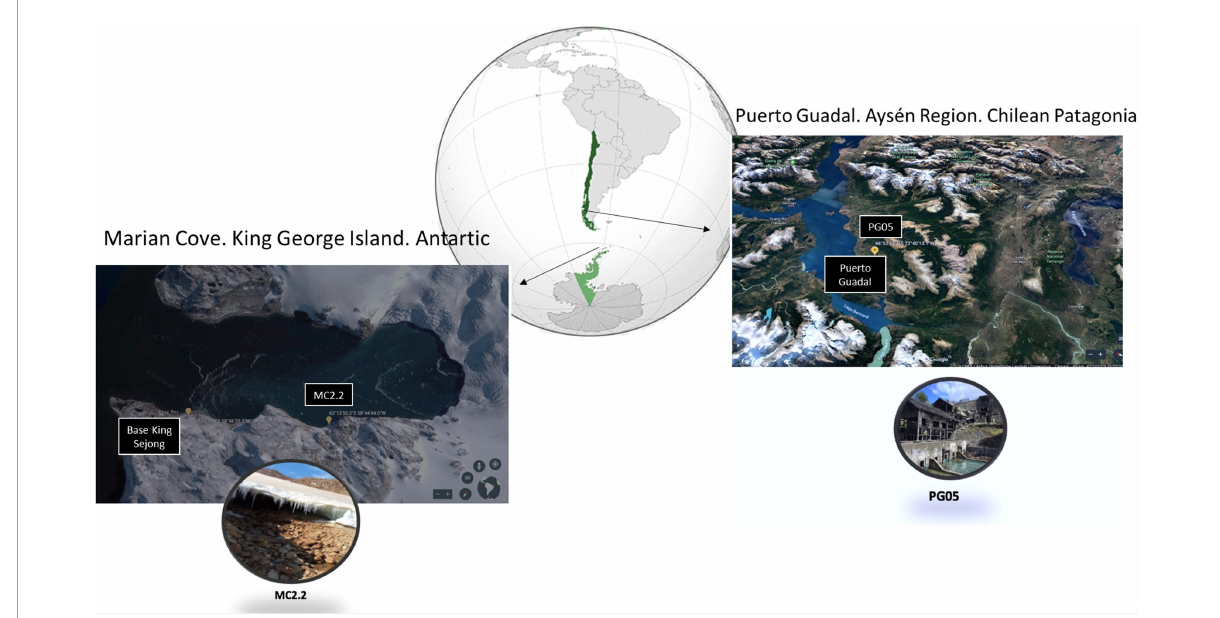
FIGURE1 Location of the sample collection sites. The insets are close-up views of AMDs in Marian Cove (left) and the Escondida mine in Puerto Guadal (right) . Map from Google